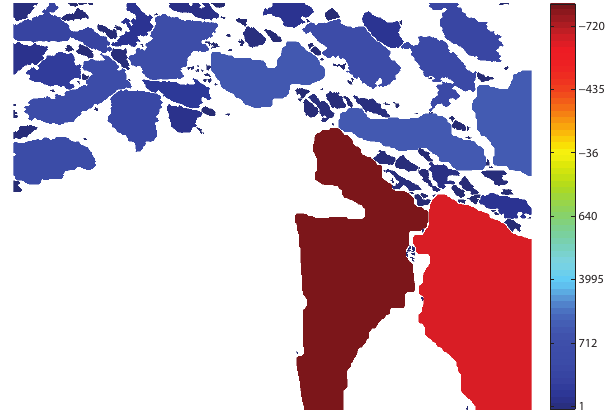
Figure 14: Identified ice floe distribution of Figure 13.